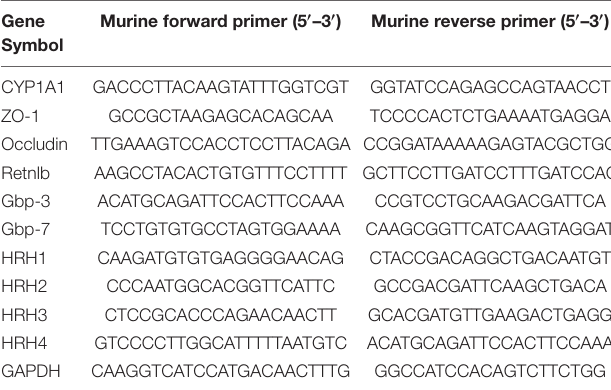
TABLE 1 | Primers used in the RT-qPCR reactions. Gene Murine forward primer (5 (cid:48) –3 (cid:48) ) Murine reverse primer (5 (cid:48) –3 (cid:48) Symbol